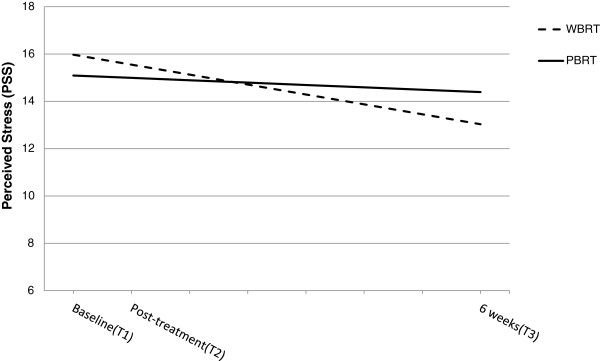
Influence of type of radiation therapy on trajectories of perceived stress. Graphical representation of the relationship between type of radiotherapy (WBRT = whole breast radiation therapy, PBRT = partial breast radiation therapy) and perceived stress (PSS scores, score range 0–40) as estimated by the hierarchical linear model from the time of the initial assessment (Baseline) to 6 weeks post radiotherapy. No group differences were found with respect to the level of perceived stress at baseline or as change over time. NS bslope-intercept = −.10 and -.42, p-values =0 .78 and 0.31.